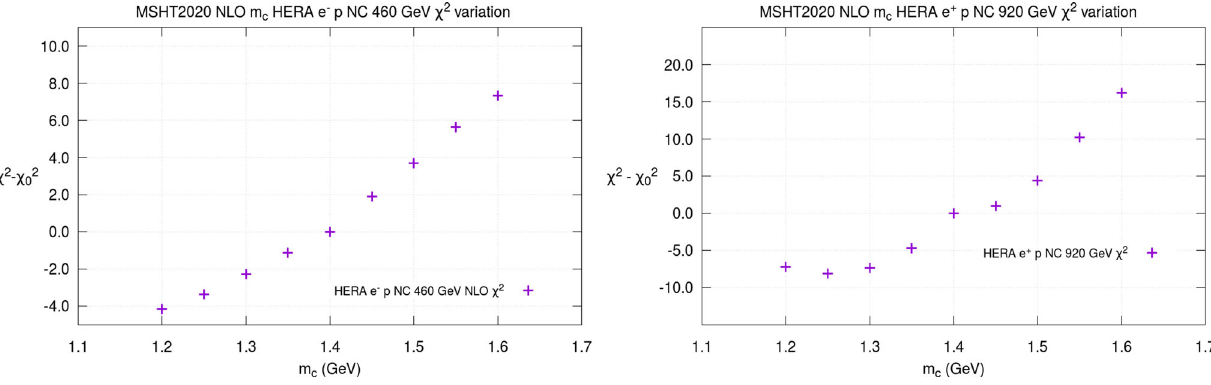
Fig. 12 The fit quality versus the quark mass m c at NLO with α S ( M 2 and ZEUS NC e − 460 GeV data and (right) NC e + 920 GeV data